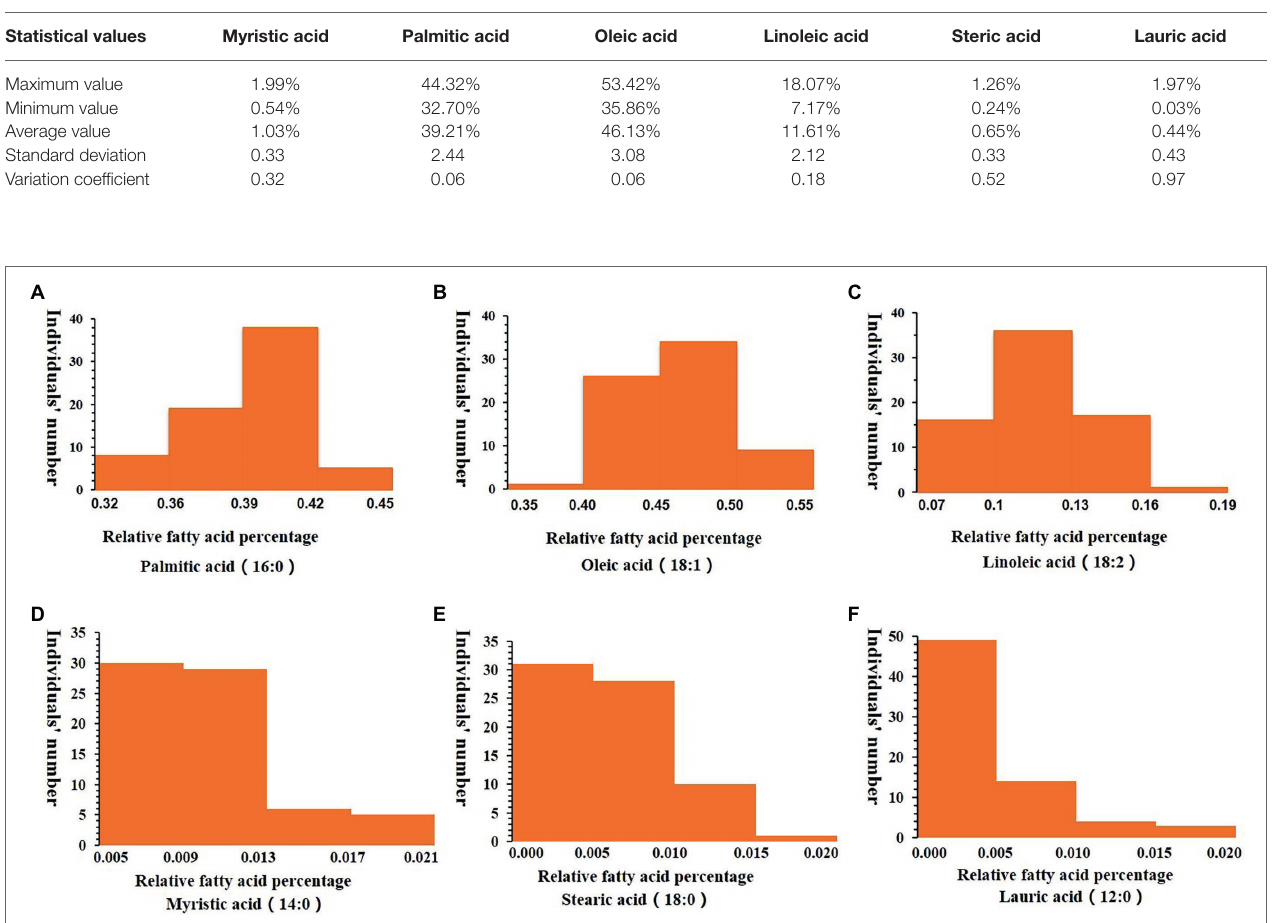
TABLE 2 | Statistical values of different fatty acid components in the population of Elaeis guineensis.